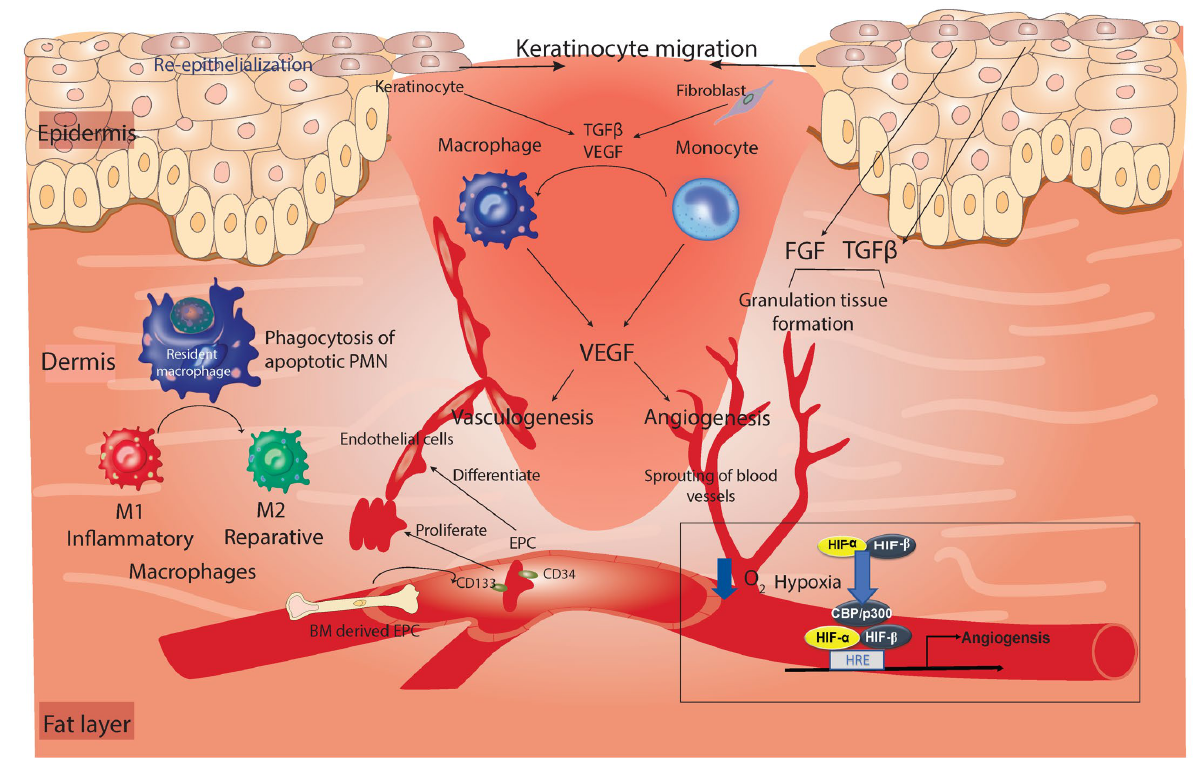
Figure 2. Summary of the late inflammation and proliferation phase of healing. Keratinocytes migrate to the wound and proliferate around the outermost area of the wound to close the wound surface by re-epithelialization. Underneath the keratinocyte layer, granulation tissue is formed and replaces the damaged dermis in a process that depends on growth factors such as FGF and TGF- β . Macrophages are differentiated from monocytes in response to TGF- β and VEGF growth factors released from keratinocytes and fibroblasts. In addition, during this phase, resident macrophages (purple-colored in the dermis) are directly involved in the elimination of inflammatory cells from the wound by engulfing apoptotic PMNs (efferocytosis). This process contributes to the switch of the macrophage’s phenotype from M1 to M2. The damaged blood vessels are replaced by neovascularization through angiogenesis, in which new blood vessels sprout from healthy vessels regulated via alterations in the oxygen gradient through HIF. Alternatively, it can form via vasculogenesis, in which endothelial cells are combined to create a new branch of the blood vessel in a process that requires EPC migration from the BM. VEGF produced from reparative macrophages or fibroblasts stimulates both processes of neo- vascularization. TGF- β , transforming growth factor beta; VEGF, vascular endothelial growth factor; FGF, fibroblast growth factor; HIF, hypoxia-inducible factor; CBP/p300, core-binding factor/protein 300; HRE, hypoxia response